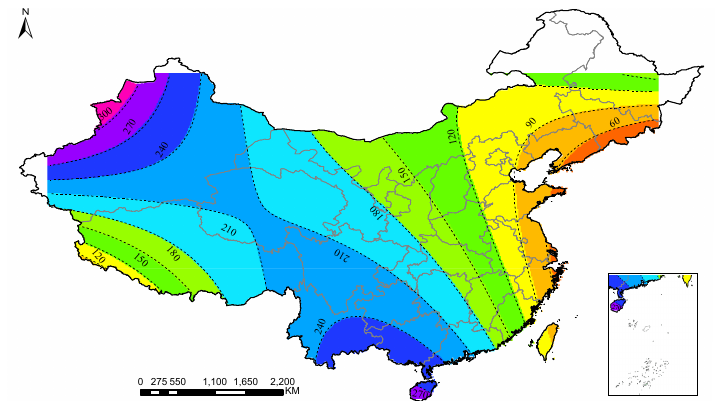
Figure 7. Contour map of the predicted spreading waves and velocity vector arrows of each case of ASF in Mainland